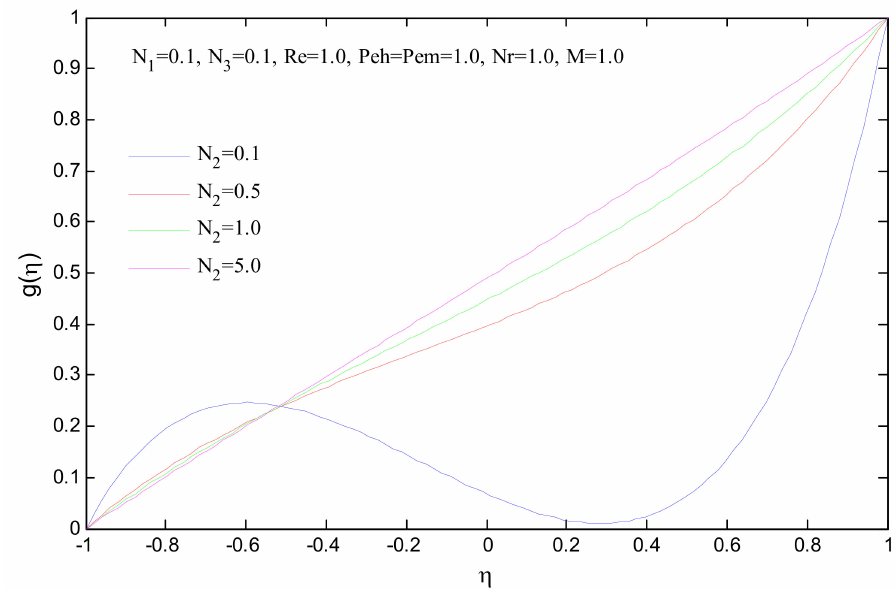
Figure 8. Effect of N 2 on microrotation profile.